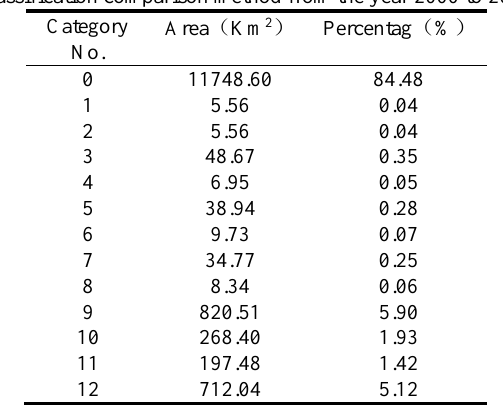
Table 7 Statistics of change detection results of